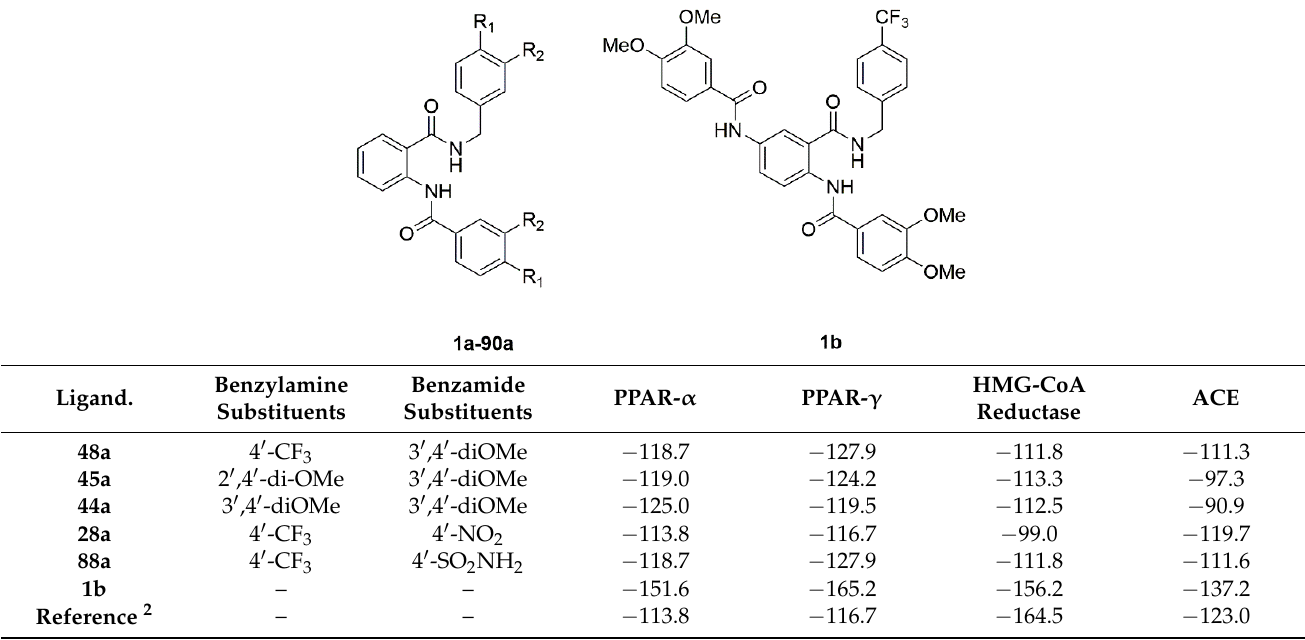
Figure 2. Docking based design of anthranilamides as multitarget drugs. Table 1. Docking scores of the ligands with higher theoretical affinity against some targets related to MetS 1 .